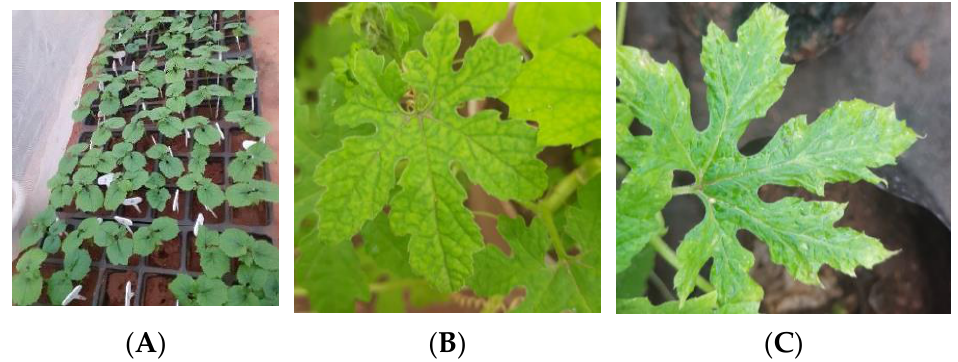
Figure 4. ( A ) Grow-out test with market and infected field seeds in glasshouse ( B ) Yellowing symptom ( C ) Mottling symptom. Table 3. Detection of begomoviruses in bitter gourd grow-out test plants in glasshouse through PCR. Sample. No Hybrid